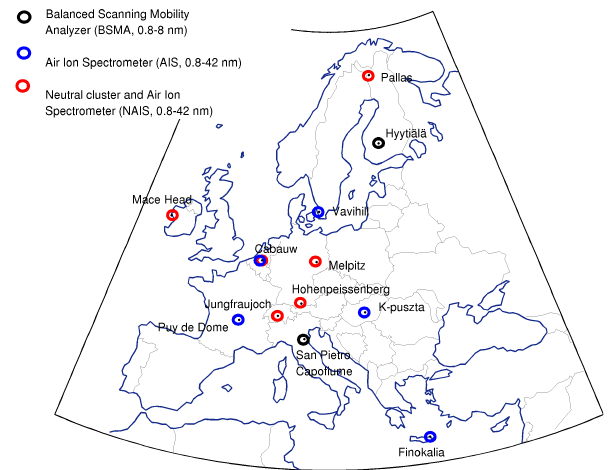
Fig. 1. Locations of the 12 field sites from where data has been used in the parameterizations. The type of ion spectrometer used at each site is indicated by the color of the circle around the